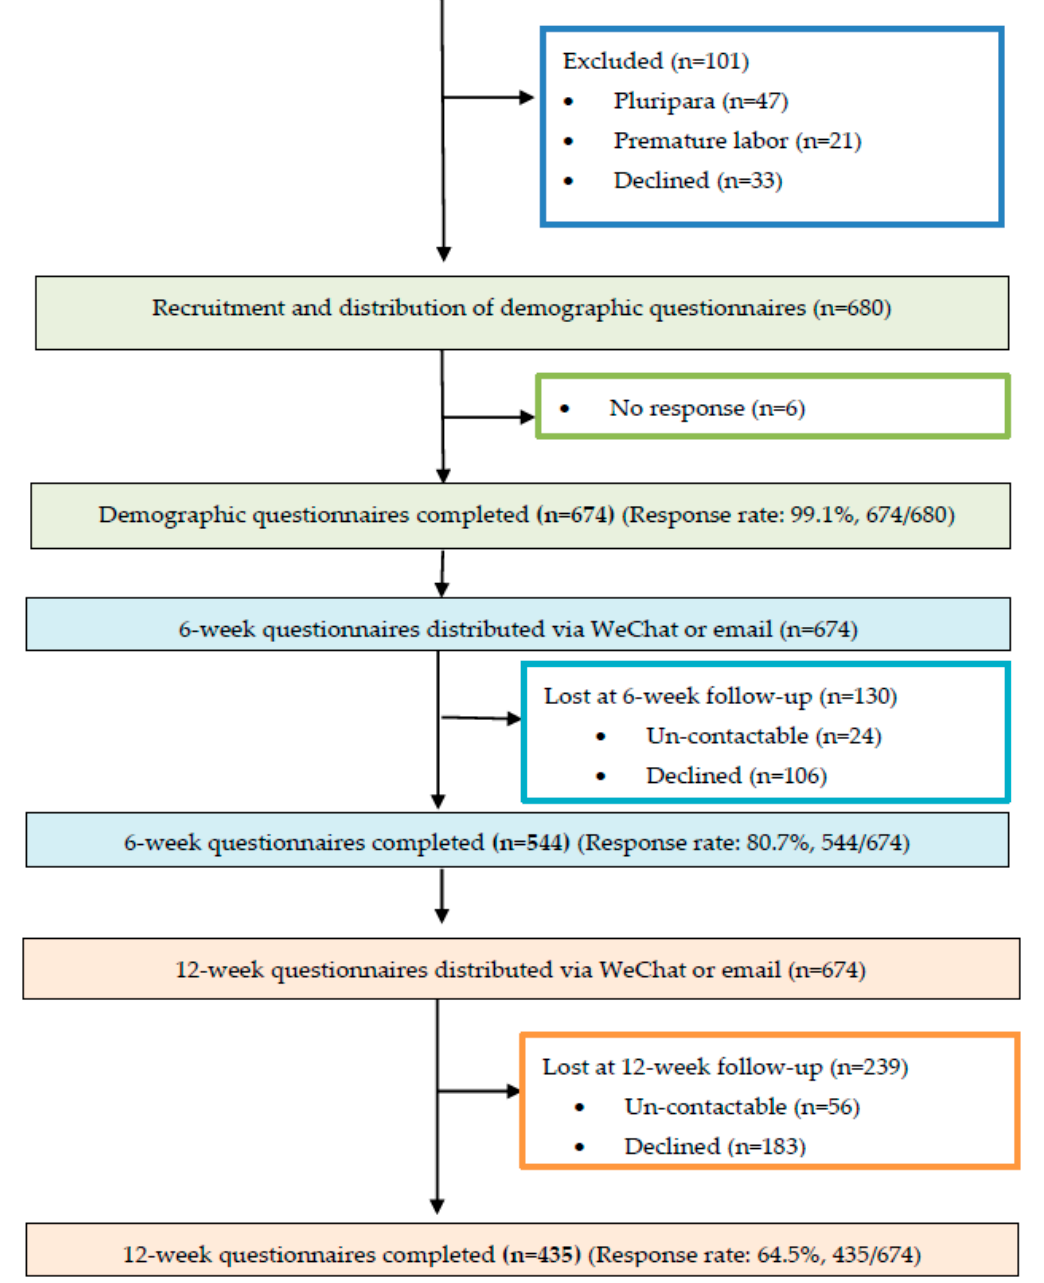
Figure 1. Flow diagram of participants and data collection.